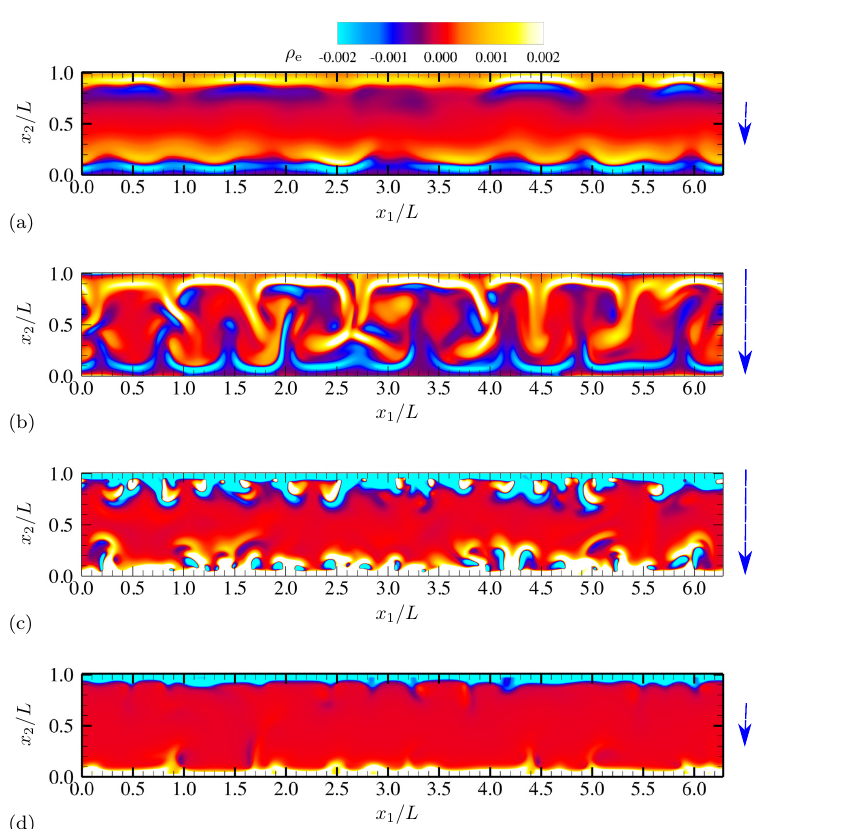
Figure 4. Time series of charge density ρ e for half an oscillation period at ( a ) θ = 0.64 π , ( b ) 0.88 π , ( c ) 1.12 π and ( d ) 1.4 π . The vertical arrows denote the direction and relative magnitude (not to scale) of the applied electric field. The diffusivity ratio is D − / D + =